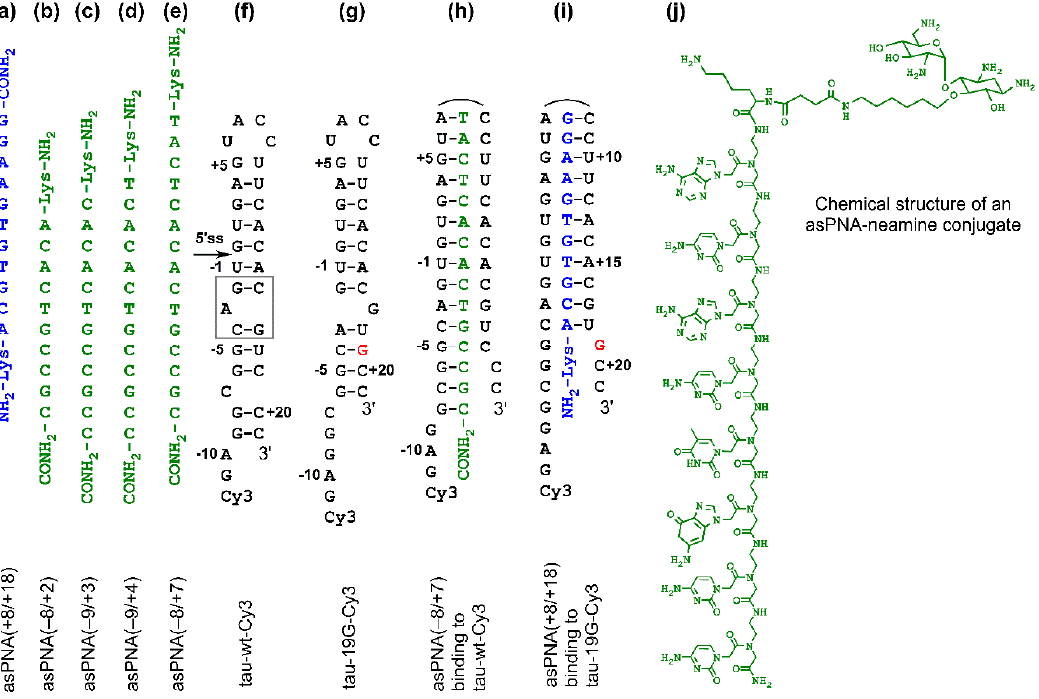
Figure 2. Sequences and structures of PNAs and RNAs. ( a – e ) PNAs studied in this paper. ( f , g ) Cy3-labeled tau pre-mRNA wild-type and mutant + 19G RNA hairpin constructs used for nondenaturing PAGE assay. The gray box represents the A bulge structure, resulting in the formation of top and bottom stems. ( h ) A complex formed between antisense PNA asPNA( − 8 /+ 7) and hairpin tau-wt-Cy3. ( i ) A complex formed between asPNA( + 8 /+ 18) and hairpin tau-19G-Cy3. ( j ) Chemical structure of a PNA–neamine conjugate. The PNA is an 8-mer and is shown for illustration purposes. The Lys residue (attached with neamine) has an L